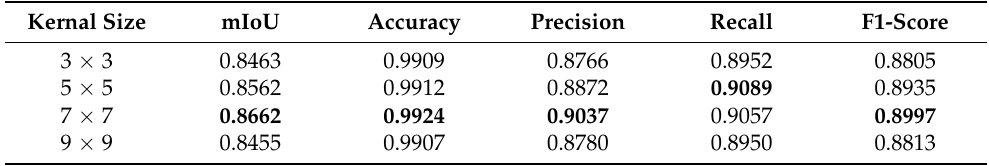
Table 3. Study of different kernel sizes in DFA modules of the DFA-UNet architecture on railway